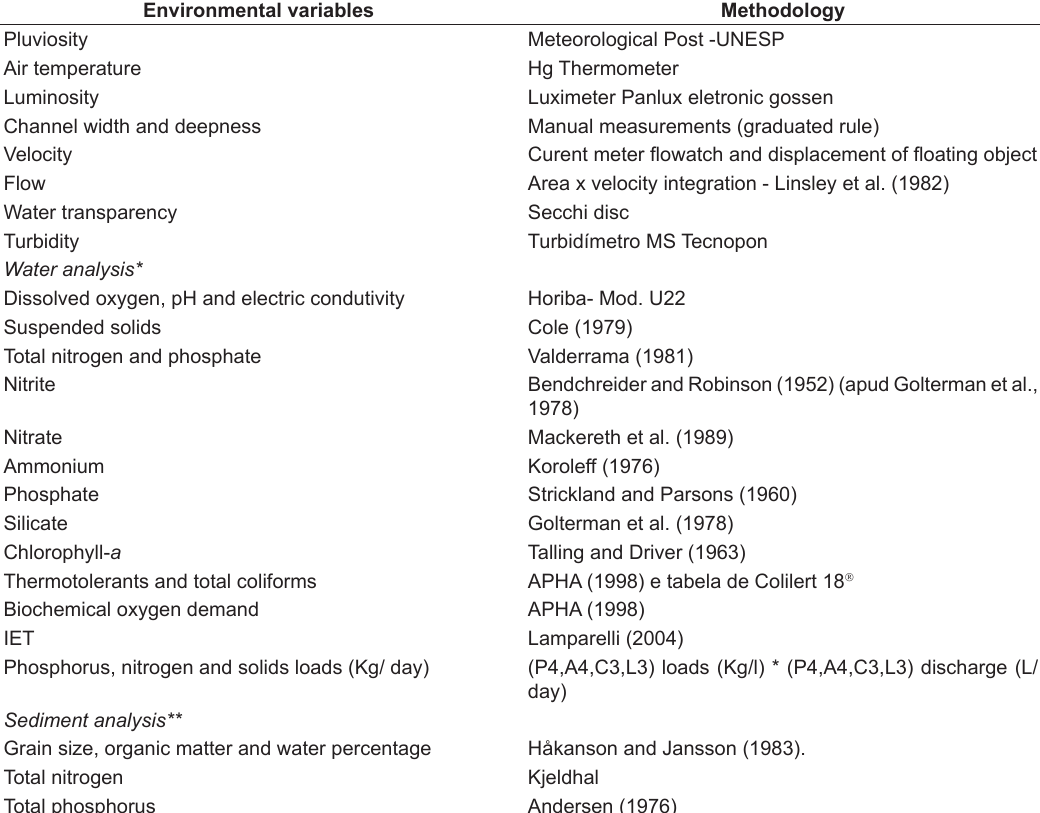
Table 2. Analyzed variables and